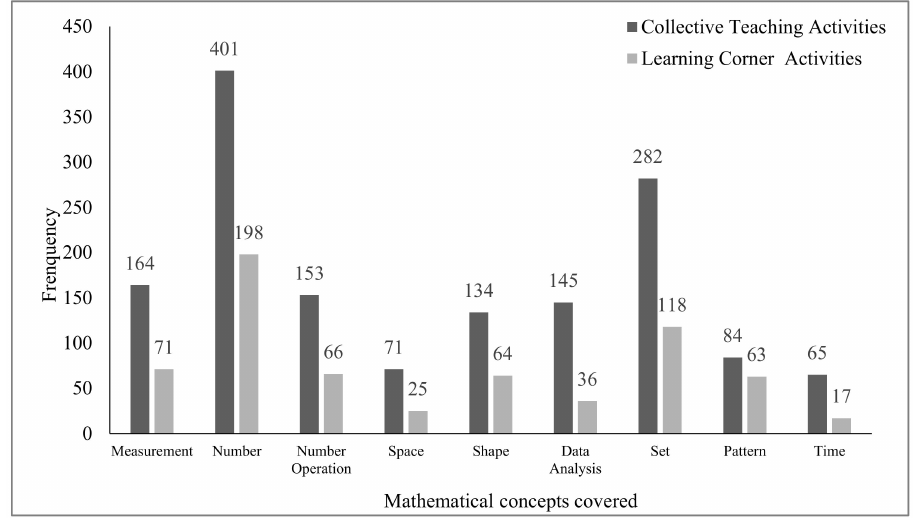
Figure 1. Distribution of different mathematical concepts covered in collective teaching and learning corner